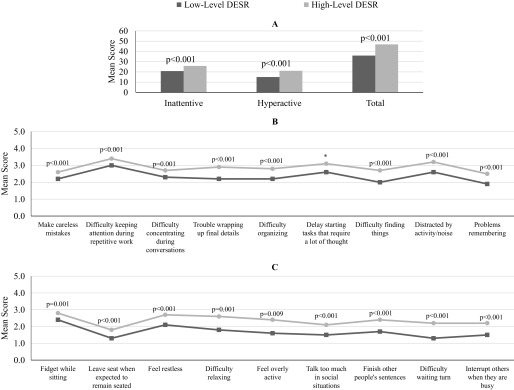
Adult ADHD Self-Report Scale scores of subjects with high (total Barkley ED score ≥ 8) and low (total Barkley ED score < 8) DESR scores. (A) Subdomain and total scores; (B) inattentive symptom scores; and (C) hyperactive symptom scores. Patients with high-level DESR were significantly more impaired than those with low-level DESR. *Significant interaction between DESR level and medication status ( p = 0.04). Stratified analyses revealed significantly higher scores in those with high-level DESR among medicated patients but not unmedicated patients.